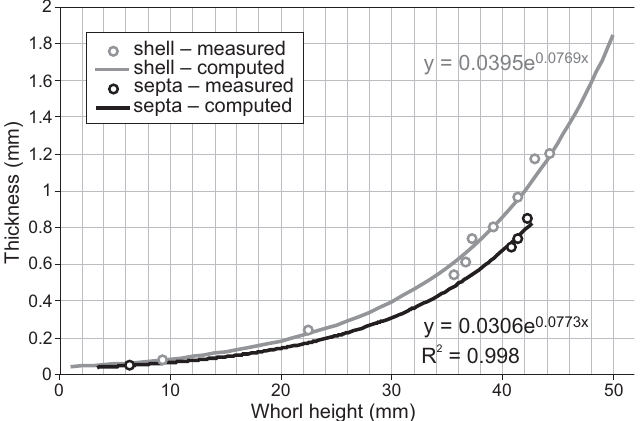
Fig. 2. Shell and septum thickness measured from three specimens of Baculites compressus (WSU-1400, WSU-1401, and WSU-1405). Expo- nential curves were fit to these points to define thickness for the full 3D model as a function of whorl